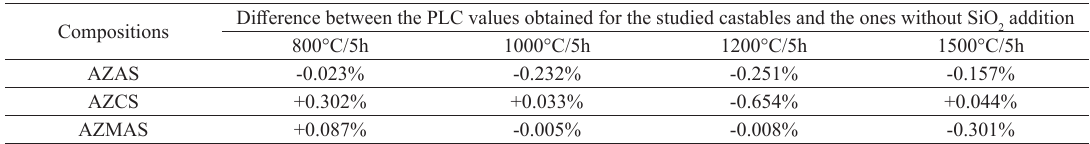
Table 6. Comparison of the permanent linear change (PLC) of the evaluated refractories with the silica-free castables presented by Pinto et al. 16 .